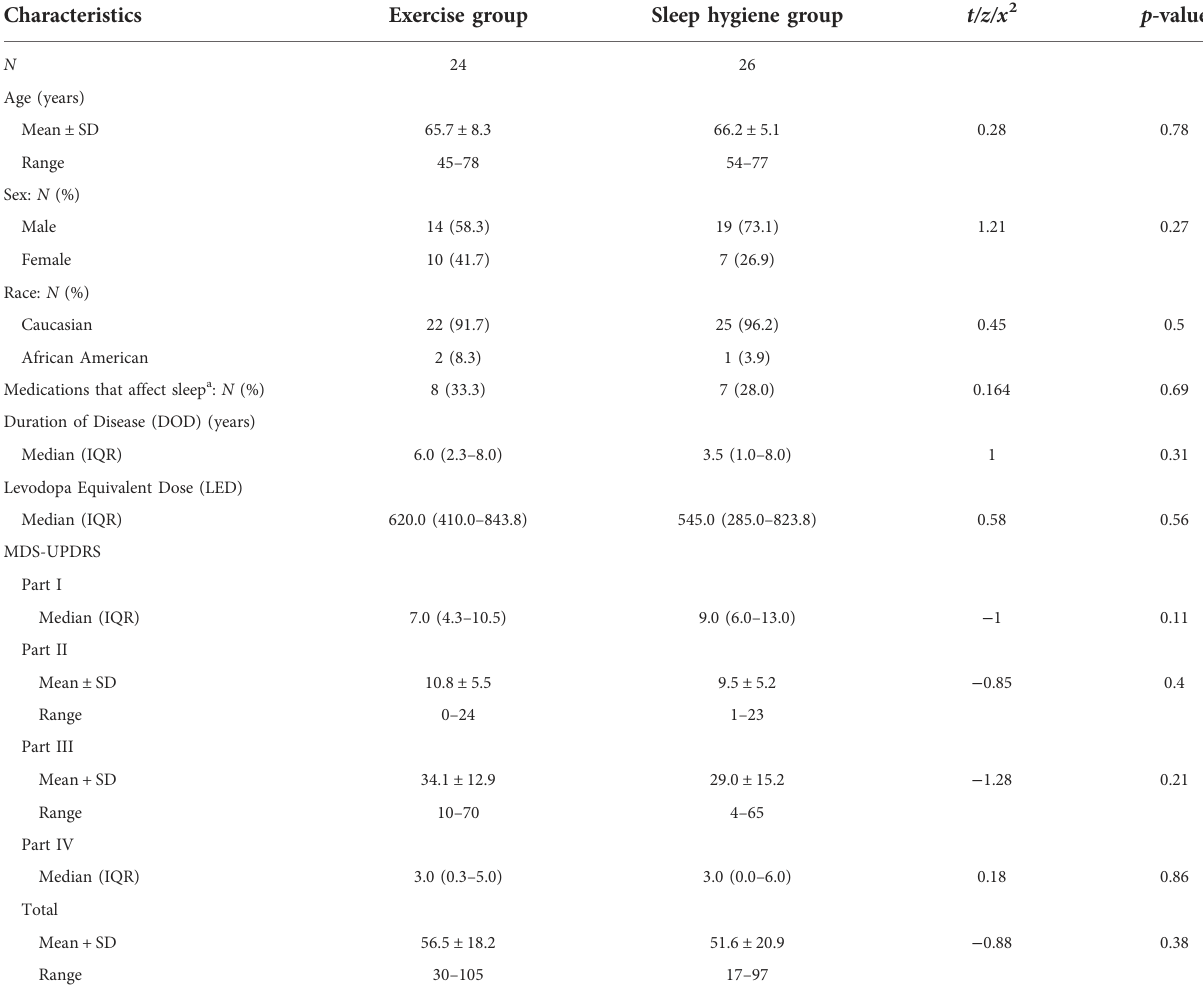
TABLE 1 Demographics and clinical